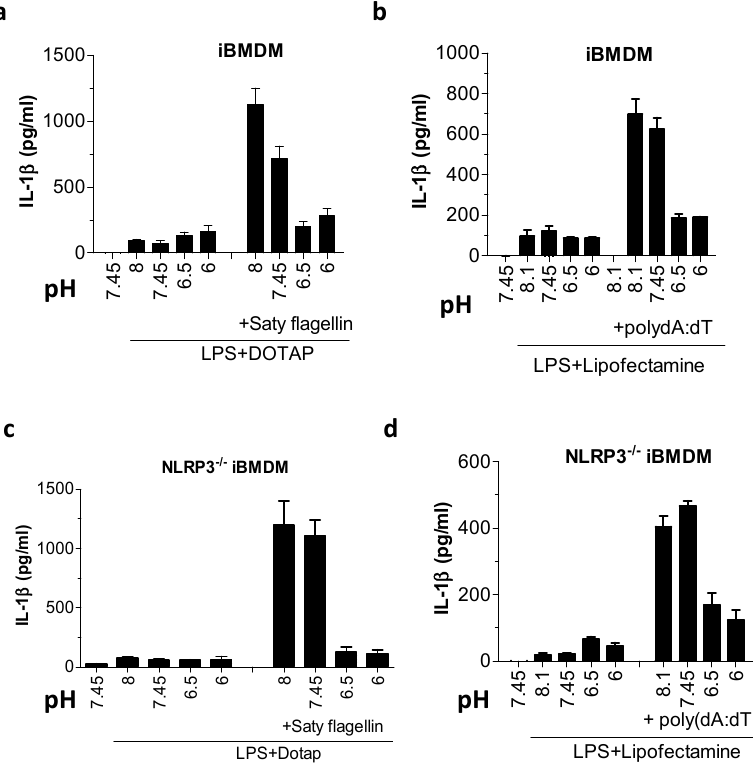
Figure 4. Acidic pH inhibited NLR family CARD domain-containing 4 (NLRC4) inflammasomes and absent in melanoma 2 (AIM2). ( a–d ) IL-1 β levels by ELISA assay after wild type (WT) iBMDMs ( a , b ) or NLRP3 -/- iBMDMs ( c , d ) were primed with 100 ng/mL LPS for 6 h and then exposed to buffers with various pH values alone, containing 3 μ g/mL Saty flagellin with DOTAP transfection reagent ( a , c ) or 2 μ g/mL poly(dA:dT) with Lipofectamine transfection reagent ( b , d ) for 3 h.